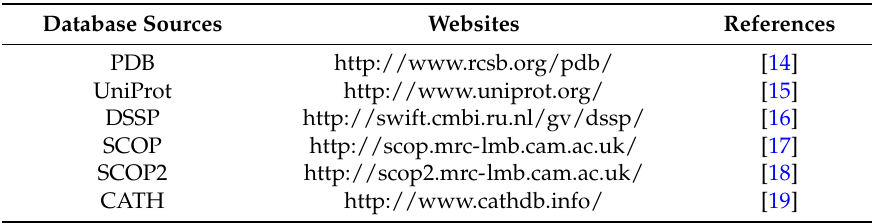
Table 1. Summary of database sources of protein structure